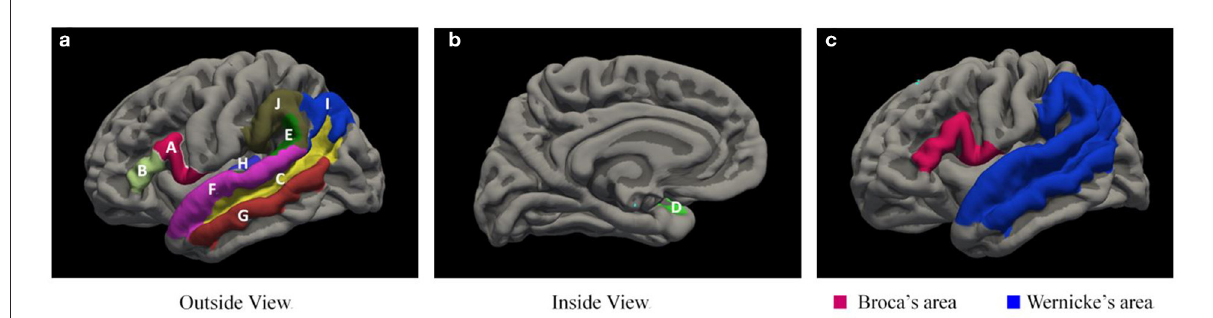
FIGURE1 Language -r elated brain areas extracted by the FREESURFER V7.0 software. (a,b) shows two brain areas contained by Broca area and eight brain areas contained in Wernicke area, and (c) shows the overall extent of Broca area and Wernicke area. A, inferior frontal gyrus pars opercularis; B, inferior frontal gyrus pars triangularis; C, Heschl’s gyrus; D, planum polare; E, planum temporale; F, superior temporal gyrus; G, middle temporal gyrus; H, superior temporal sulcus; I, angular gyrus; J, supramarginal